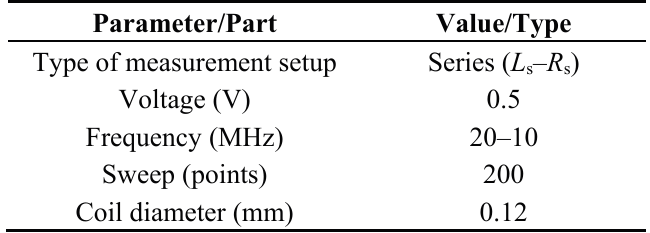
Table 2. Specification for frequency characteristics experimental setup.